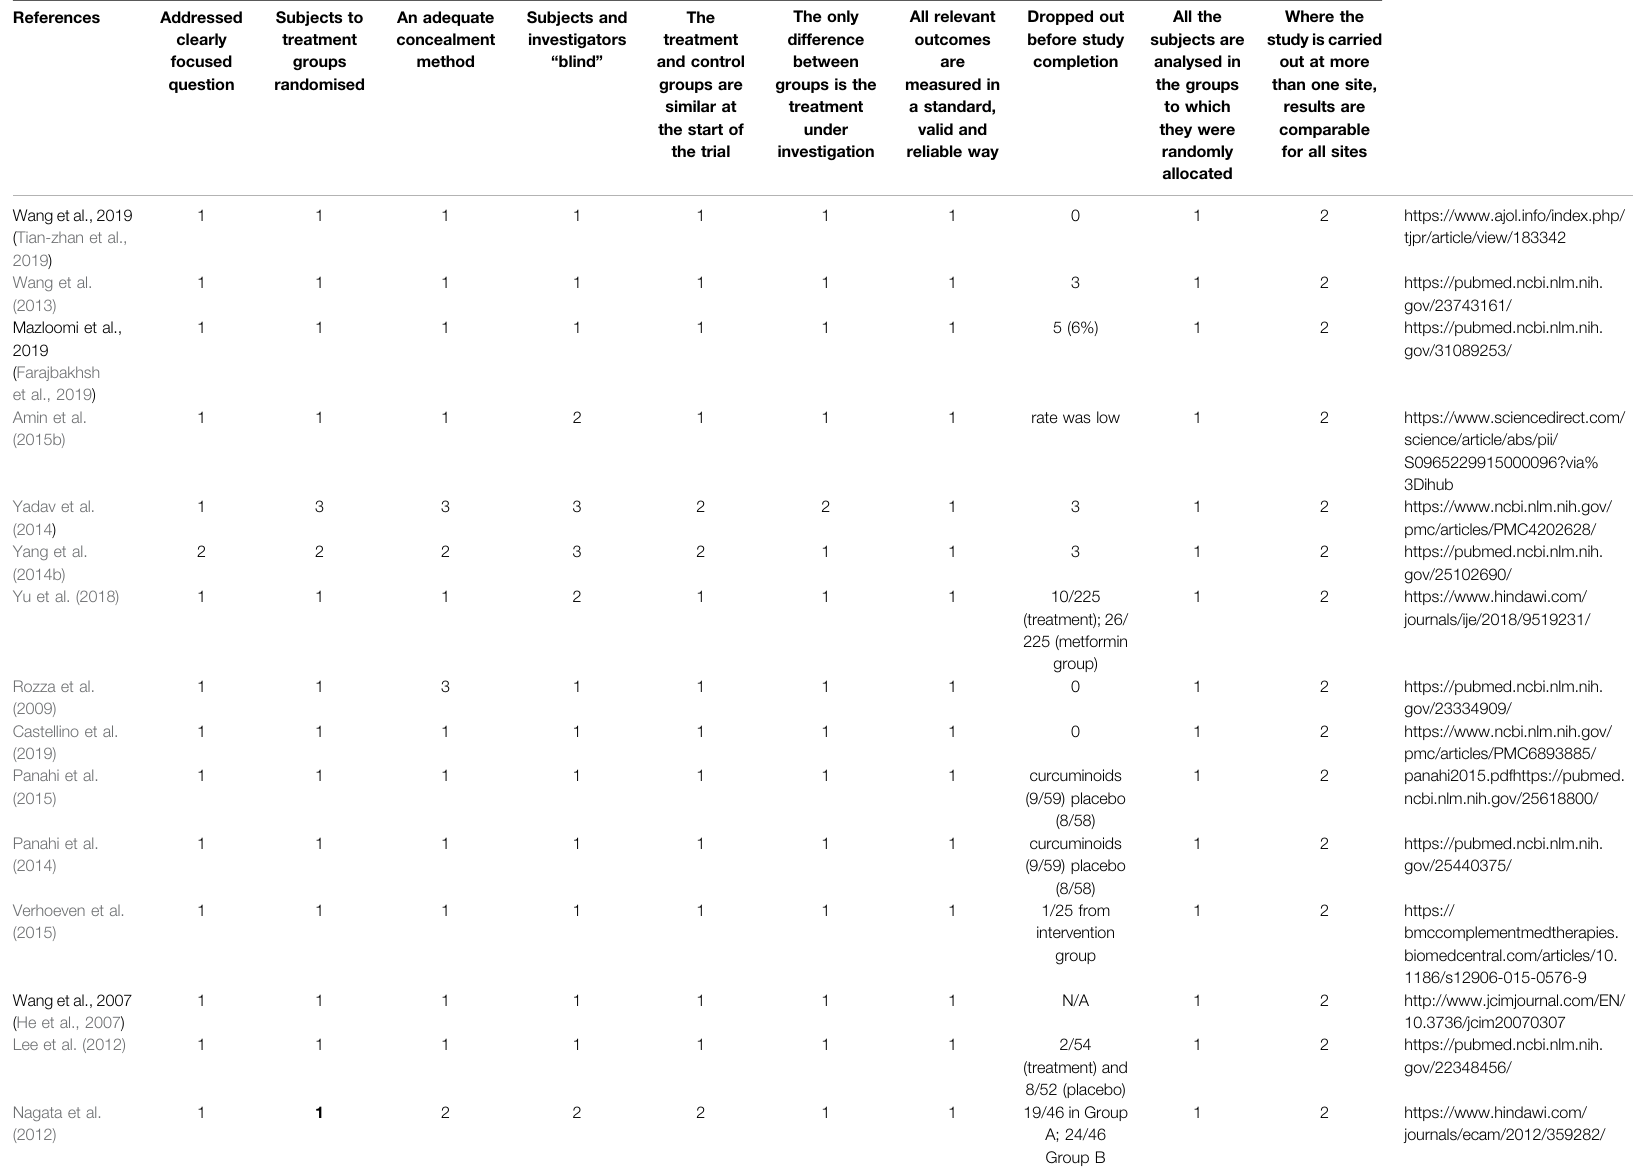
TABLE 6 | Qualitative scoring of clinical